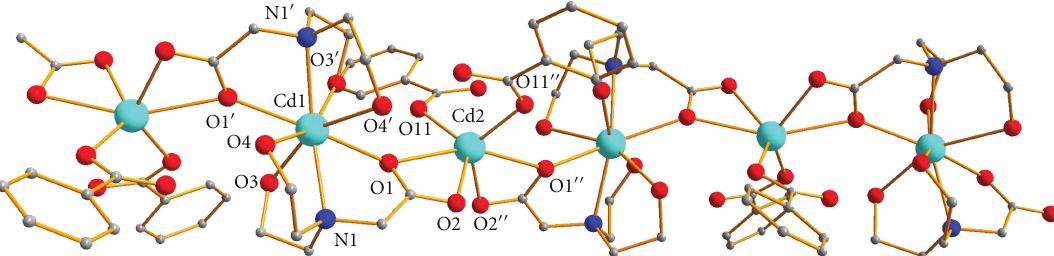
Figure 1: Partially labeled plot of a portion of the chain that is present in complex 1 . Single and double primes are used for symmetry-related atoms (see footnote of Table 2).